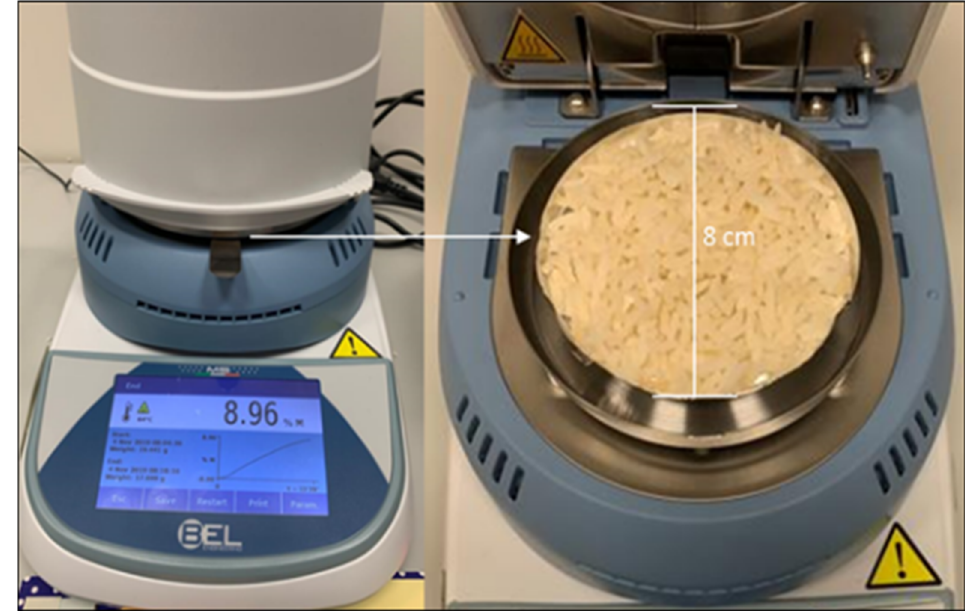
Figure 3. Moisture analyzer used to control the moisture level of the raw material.